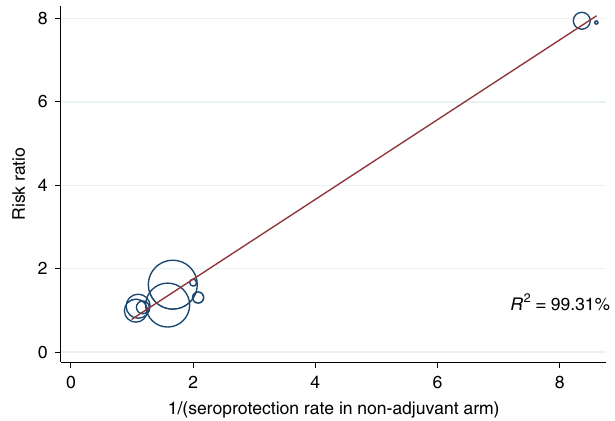
Fig. 6 Meta-regression showing a linear relationship (slope = 0.96, P < 0.001) between the ratios of the seroprotection rate against H3N2 after the fi rst dose and the inverse of seroprotection rate in non-adjuvanted arm, with an R 2 of